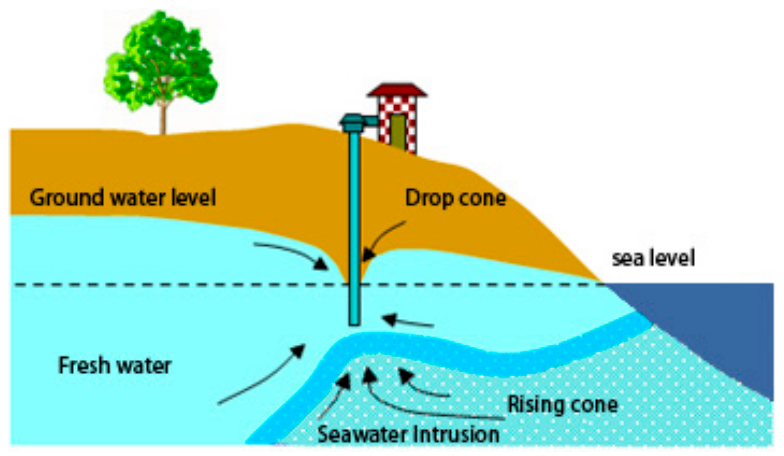
Figure 1. Diagram of seawater intrusion caused by the overpumping of groundwater.